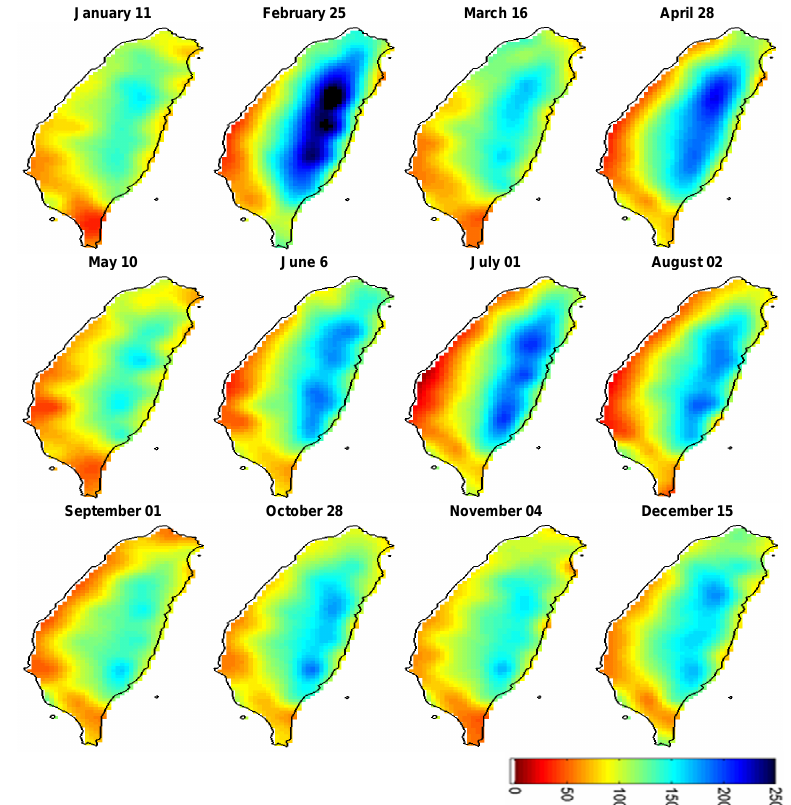
Figure 5. Evolution of resampled 1-km resolution AMSR-E surface soil moisture (g cm -3 ) in 2009.